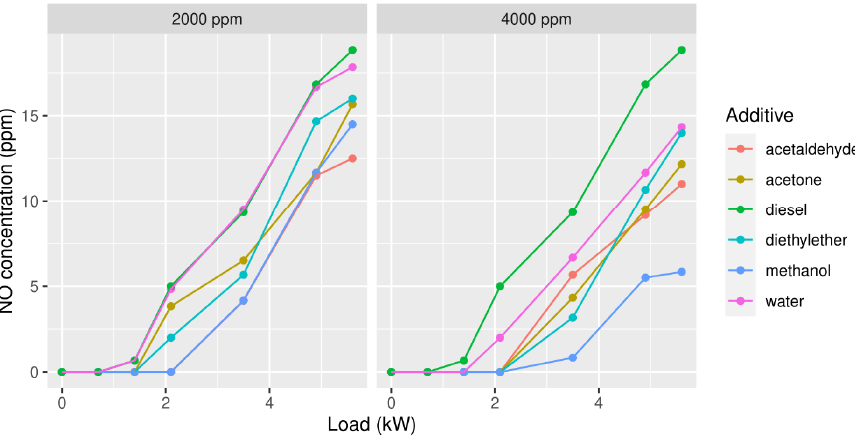
Figure 2. Concentrations of NO in the exhaust gas in function of the load, with 2000 ppm ( left column ) or 4000 ppm ( right column ) of each of the oxygenates added to the diesel.